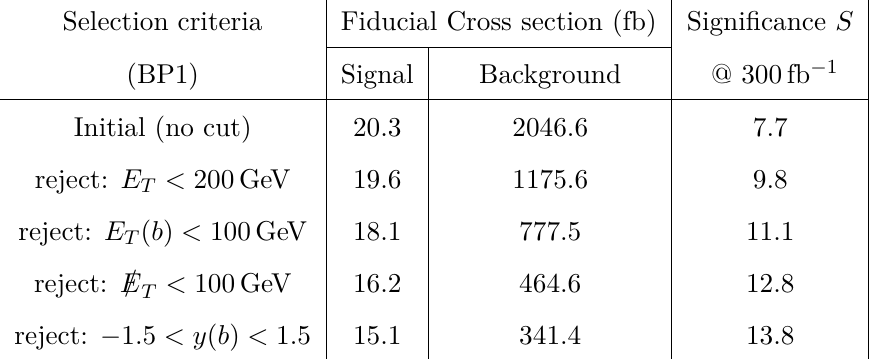
Table 11 . Fiducial cross section of the signal ( pp → d 0 d 0 → bb H 0 ground ( pp → bbνν ) corresponding to BP1 at 14 TeV LHC, with and without the selection criteria considered, and the signal significance at the